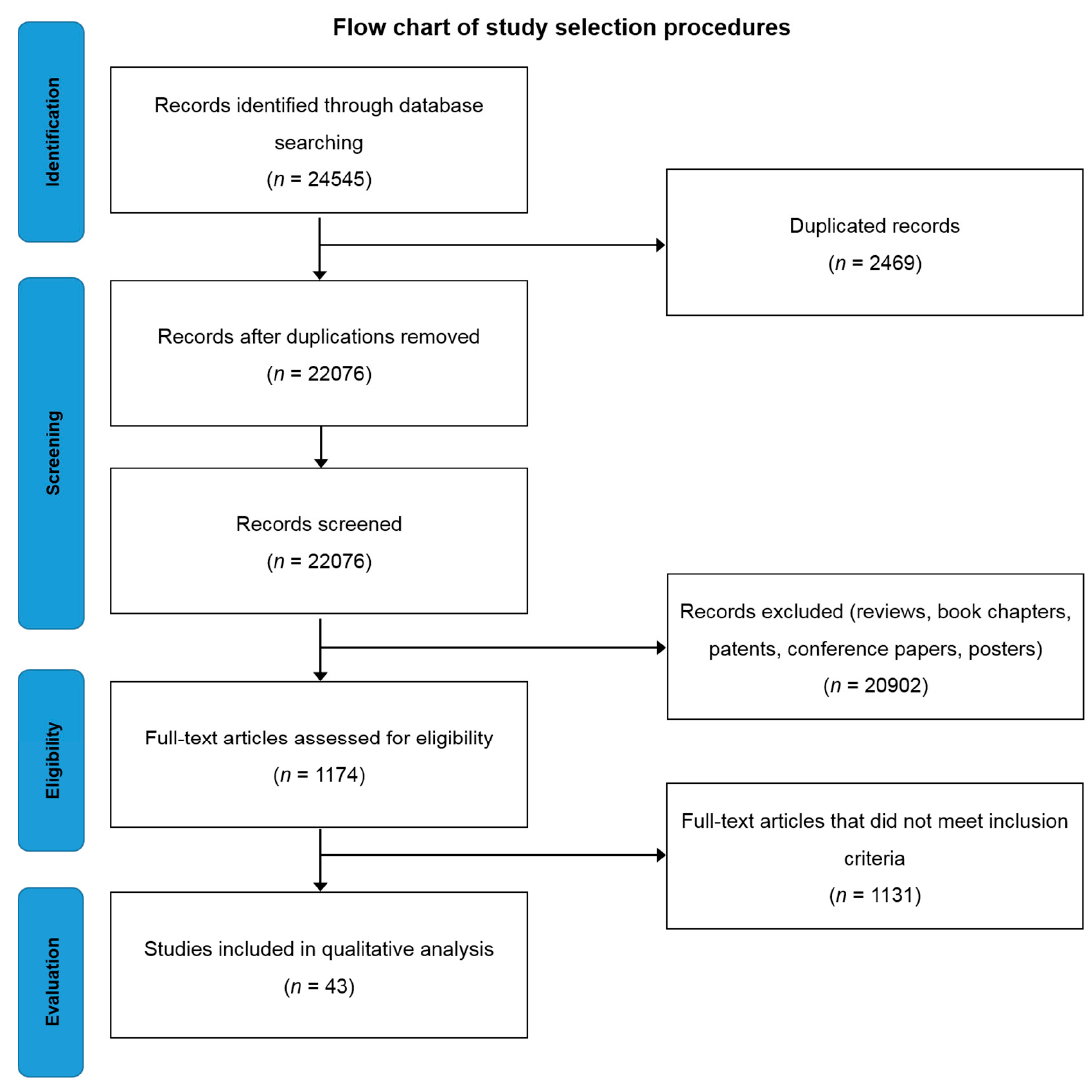
Figure 1. Flow chart of study selection criteria based on Preferred Reporting Items for Systematic Reviews and Meta-Analyses (PRISMA) guidelines.